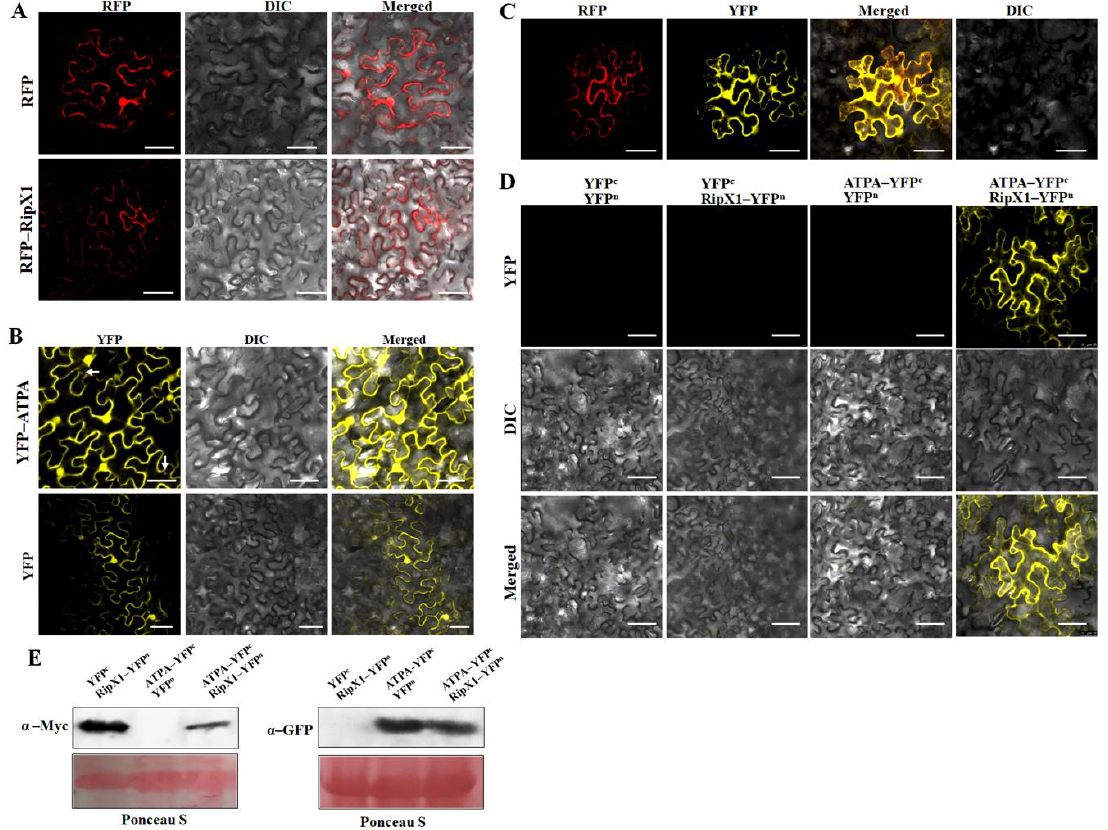
Figure 4. Subcellular localization of ATPA and its interaction with RipX1 in N. benthamiana cells. ( A ) Subcellular localization of RFP-RipX1. ( B ) Subcellular localization of YFP-ATPA. The arrows indicate the localization of YFP-ATPA in mitochondria. ( C ) Colocalization of RFP-RipX1 and YFP-ATPA in N. benthamiana cells. ( D ) BiFC analysis showing the spatial interaction of ATPA and RipX1 at the cell membrane. ( E ) Protein expression levels in the infiltrated plant leaves were collected for immunoblotting assays with anti-GFP and anti-Myc antibody. Ponceau S staining indicates the equal loading of the proteins. All experiments were repeated three times. The scale bar represents 50 μm.